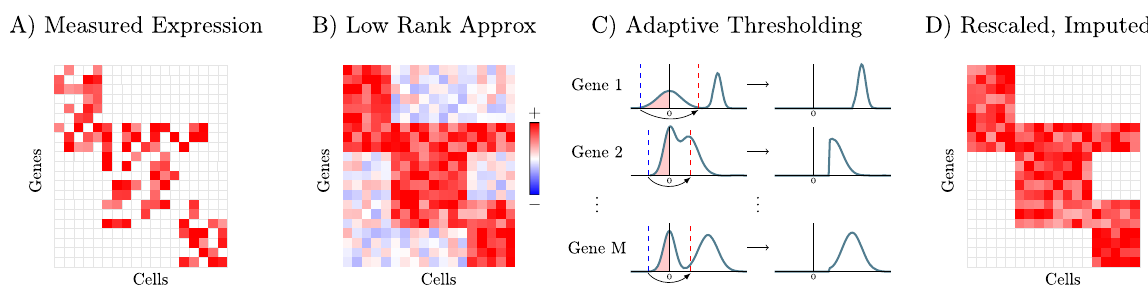
Fig. 1 Overview of the ALRA imputation scheme. A Measured expression matrix contains technical zeros (in each block) and biological zeros (outside each block). B Low-rank approximation via SVD results in a matrix where every zero is completed with a non-zero value (i.e., biological zeros are not preserved). C The elements corresponding to biological zeros for each gene are symmetrically distributed around 0, so the magnitude of the most negative elements in each row is also approximately the magnitude of the most positive values assigned to biological zeros. Therefore, thresholding the values in each row, restores almost all of the biological zeros in the imputed matrix ( D